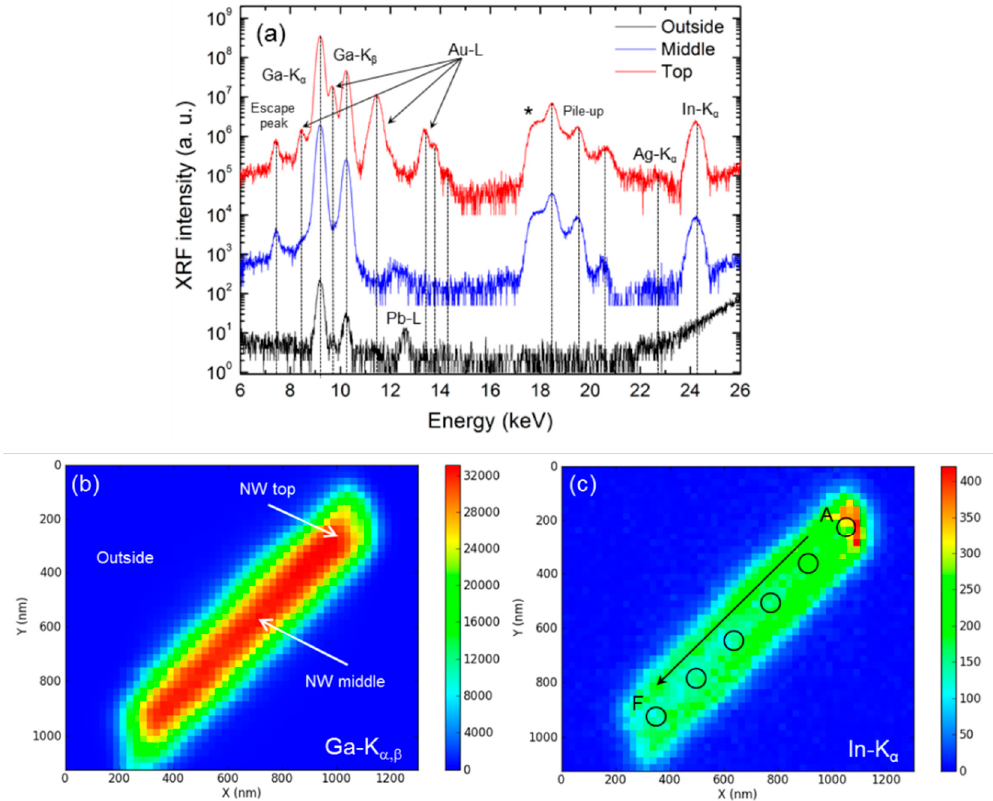
Figure 3. ( a ) Averaged X-ray flouresence (XRF) spectra from locations at the top (red) and middle (blue) of the NW, and at an outside region (black). The labels indicate the elements associated with each peak identified with PYMCA. The asterisk represents an artefact coming from the measurements. The XRF intensity color maps of Ga and In in the scanned area are shown in ( b ) and ( c ), respectively. Red (blue) color corresponds to high (low) fluorescence intensity (scale in counts). The black circles in ( c ) indicate the regions of the NW along its axis in which the In concentration has been estimated.